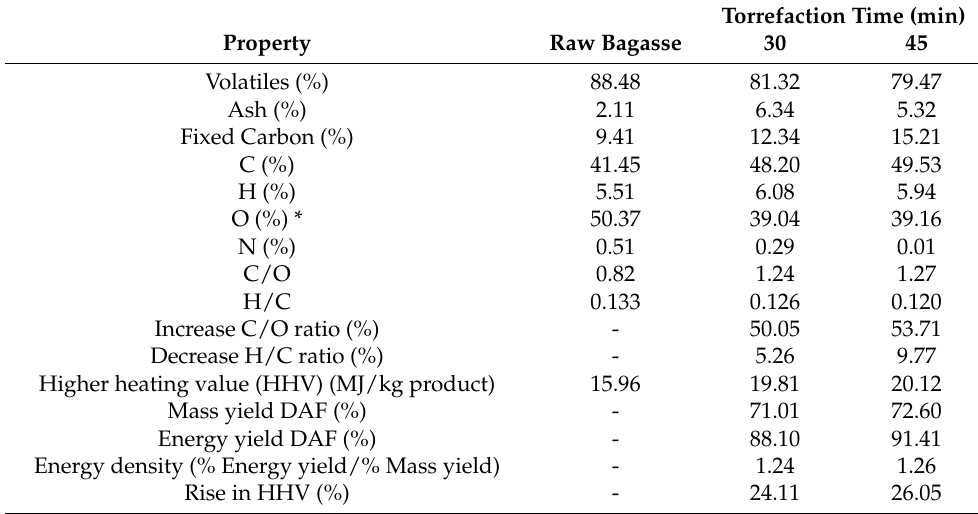
Table 5. The proximal and ultimate composition of torrefied sugarcane bagasse at 280 ◦